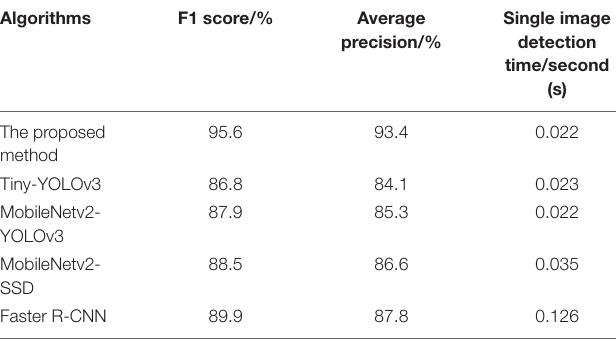
TABLE 5 | Comparison of detection results using different